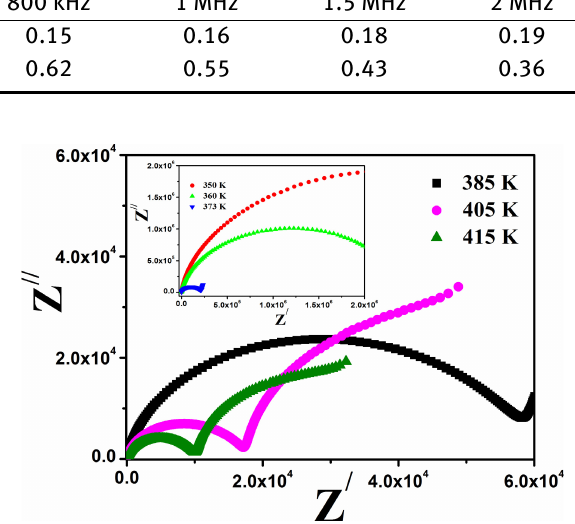
Figure 4: Impedance spectra of the film at higher temperatures (in- set shows Impedance spectra of the sample at lower